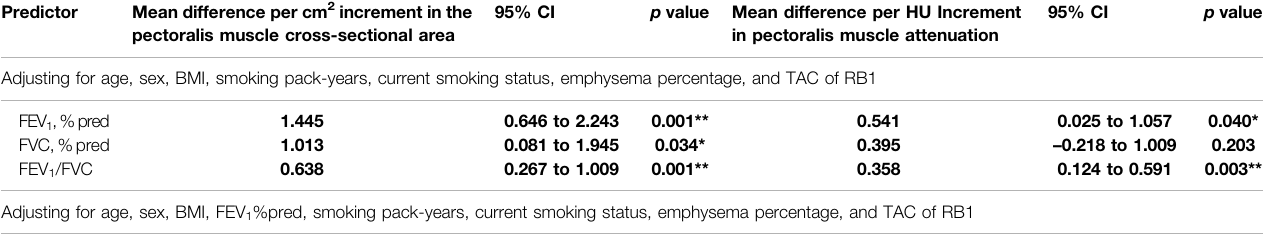
TABLE 4 | The regression analyses between PMA and PMT with clinical characteristics in patients with stable COPD. Predictor Mean difference per cm 2 increment in the 95% CI p value Mean difference per HU Increment 95% CI p value pectoralis muscle cross-sectional area in pectoralis muscle attenuation Adjusting for age, sex, BMI, smoking pack-years, current smoking status, emphysema percentage, and TAC of RB1